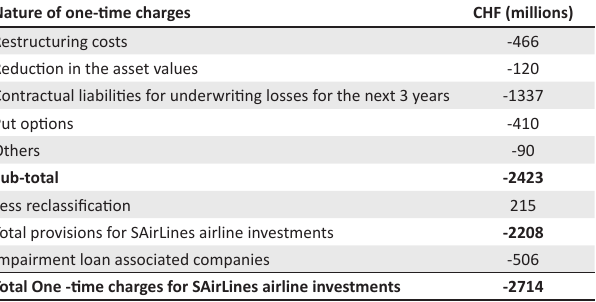
TABLE 4: One-time charges for SAirLines airline investments. Nature of one-time charges CHF